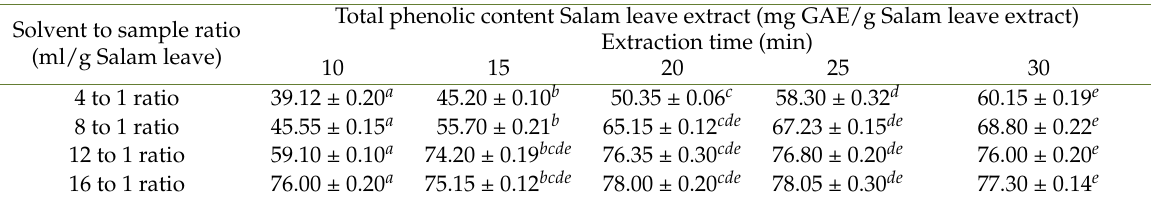
Table 2. Total phenolic content Salam leave extract Solvent to sample ratio